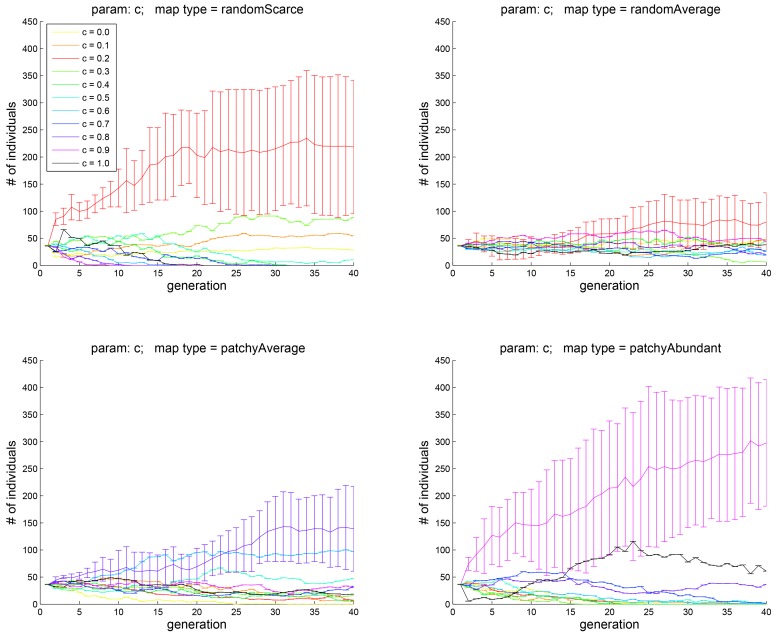
Experiment 1A: the effect of the parameter c, which controls the relative contributions to motivation of the hedonic well-being H and eudaimonic well-being E (see Eq 4).In each simulation, the initial population consistent of 11 cohorts, over which the value of c ranged from 0 to 1 in increments of 0.1. The four subplots correspond to the four different map types shown in Fig 2. The abscissa shows the generation number; the ordinate is the number of individuals in each cohort. See text for interpretation.